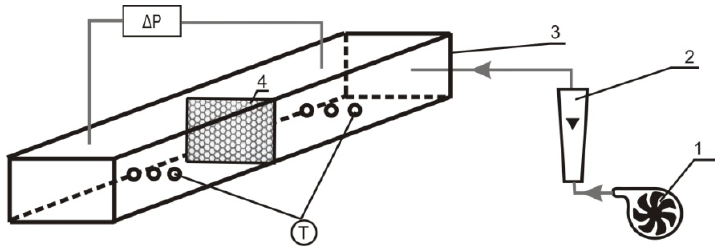
Figure 10. Experimental setup: 1-blower, 2-rotameter, 3-reactor, 4-sample, T-thermocouples.